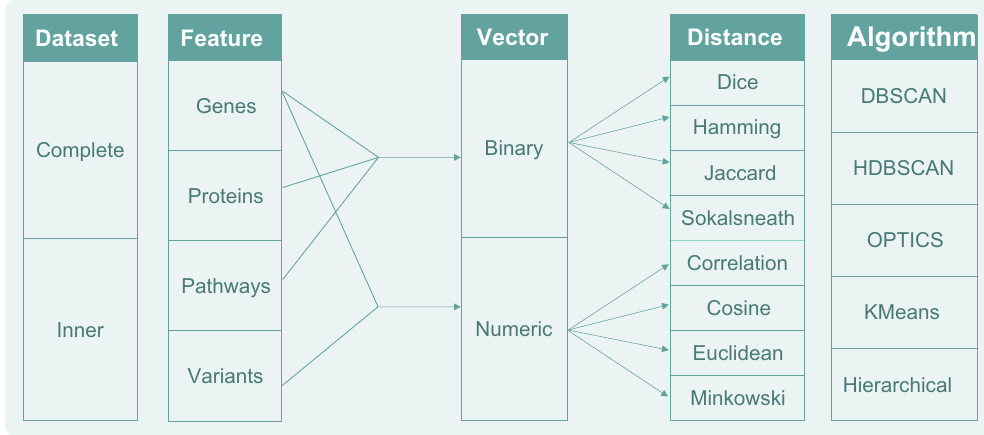
Figure 6. Schematic representation of the considered factors involved in the current analysis methodology. Each phase of the performed analysis contemplated different variables, leading to different combinations of the possible inputs that would in turn lead to different outcomes. The figure illustrates the possibilities for the different used datasets, features, vector types, distance metrics and clustering algorithms.